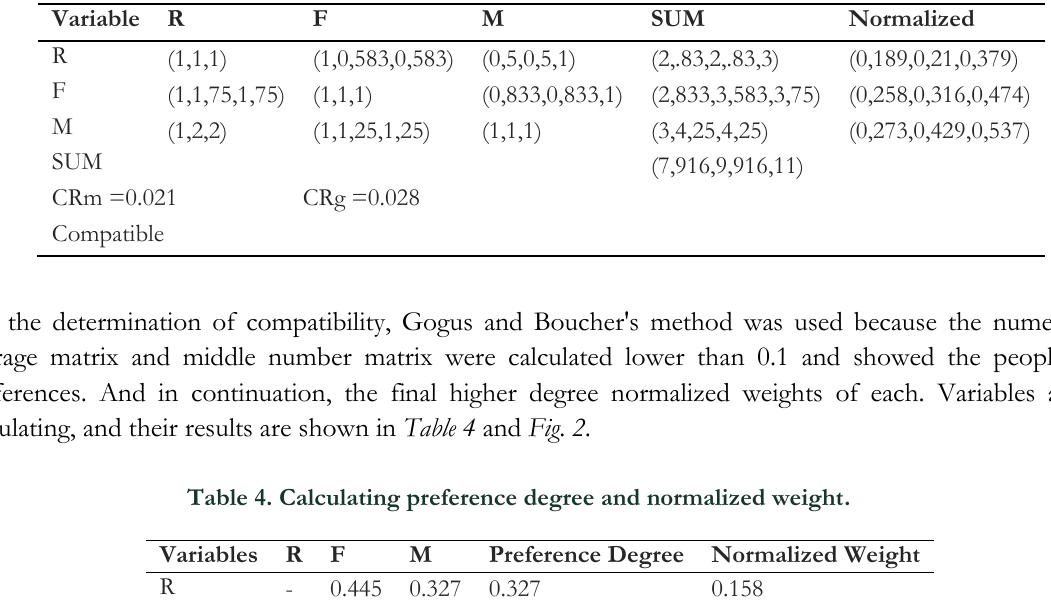
Table 3. Matrix average of expert people ideas.